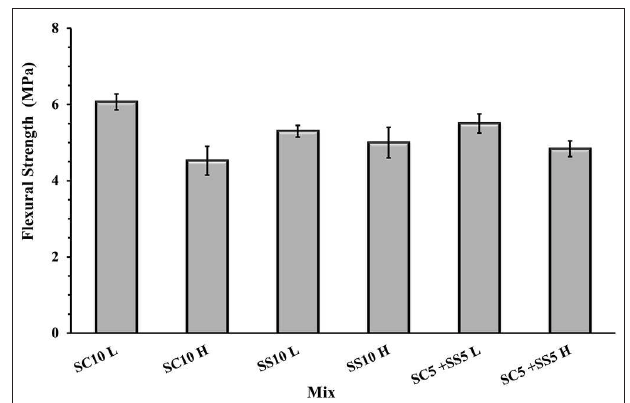
FIGURE 3 | Flexural test results of concrete beams after 28 days of sealed curing.